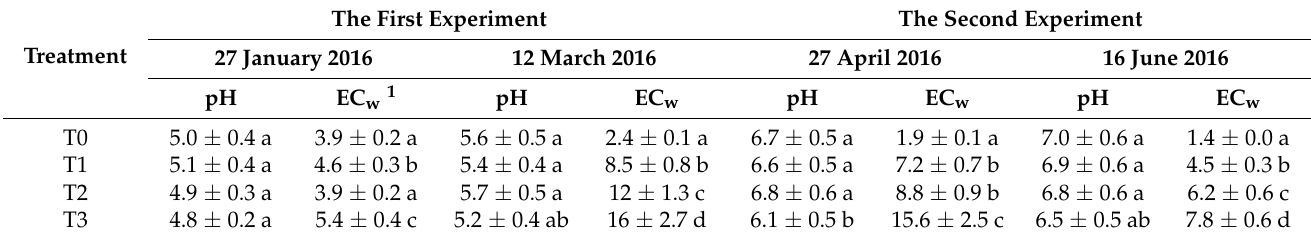
Table 1. The pH and electrical conductivity (EC w ) of the drainage water. Different letters within a column represent significant differences ( p ≤